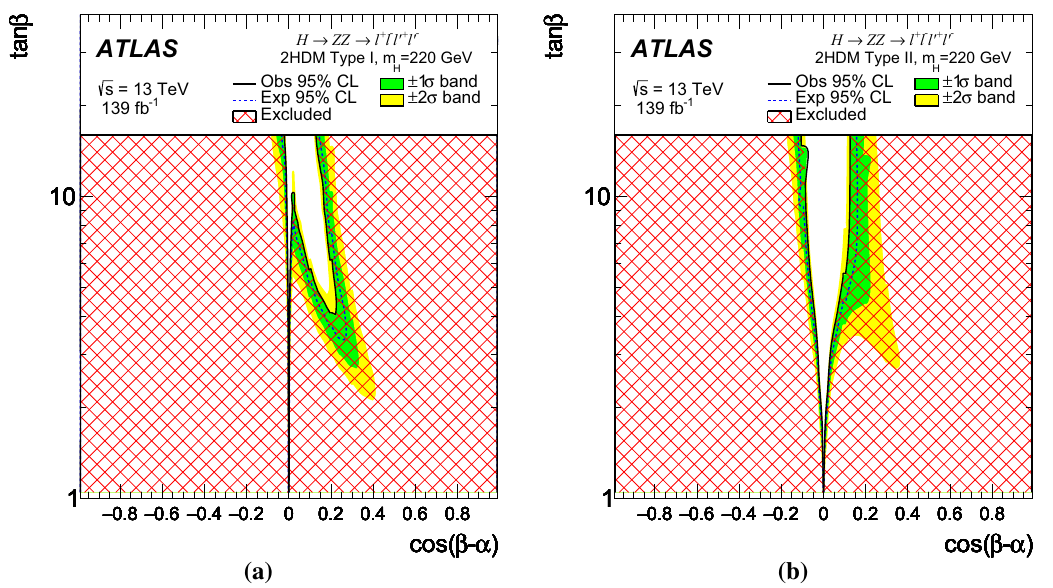
Fig. 6 The exclusion contour in the 2HDM a type-I and b type-II models for m H = 220 GeV shown as a function of the parameters cos (β − α) and tan β . The green and yellow bands represent the ± 1 σ and ± 2 σ uncertainties in the expected limits. The hatched area shows the observed